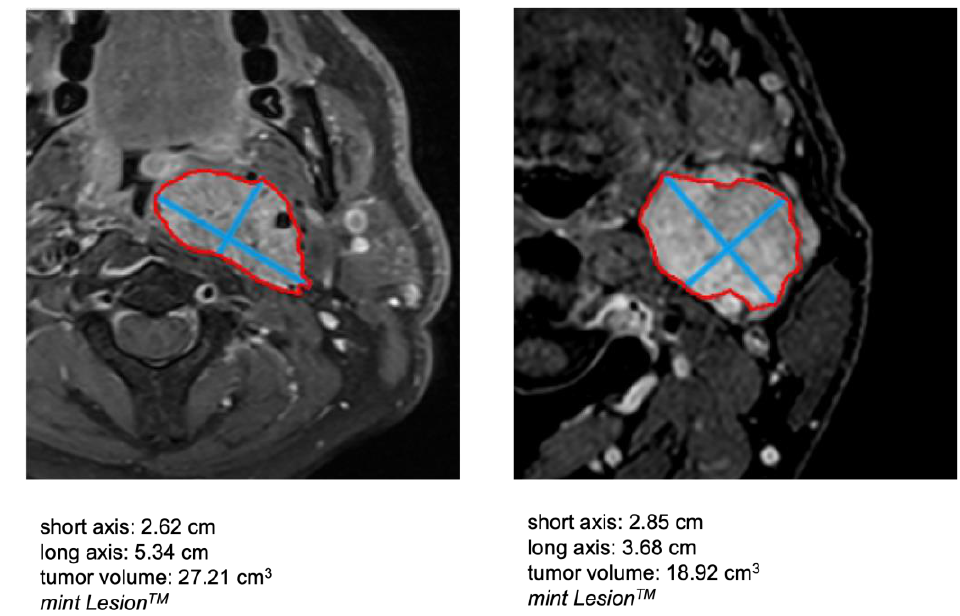
Figure 1. Three-dimensional tumor segmentation for tumor volume calculation (mint Lesion TM ).